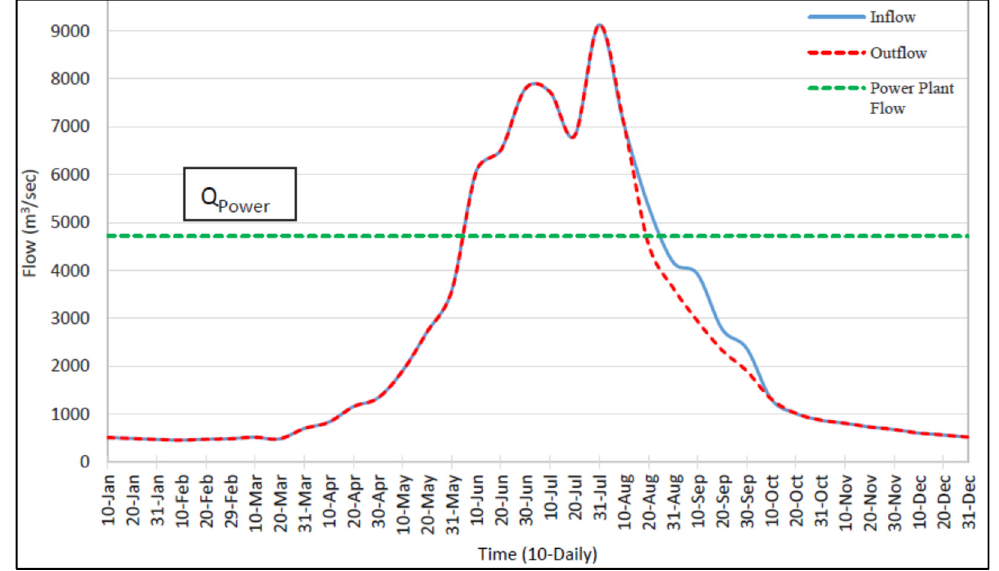
Figure 34. Inflow-Outflow Hydrographs of Application year 2030.